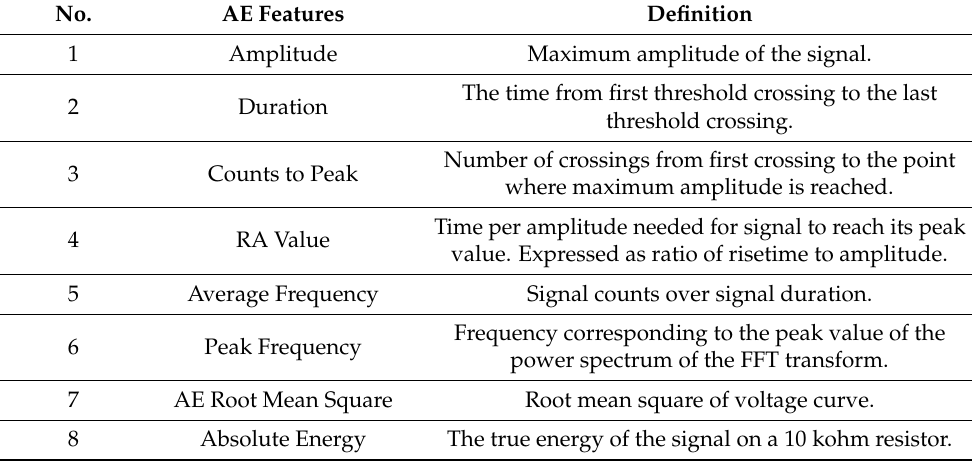
Table 2. Selected AE features (after hierarchical clustering) and their